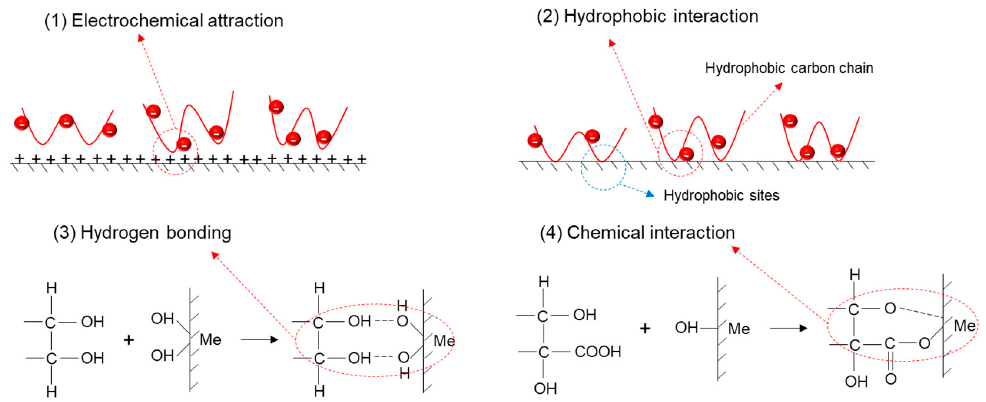
Figure 40. Possible mechanisms of interaction of organic polymers with the mineral surface: ( 1 ) elec- trochemical attraction, ( 2 ) hydrophobic interaction, ( 3 ) hydrogen bonds, and ( 4 ) chemical interaction. Figure adapted from (adapted from Mu et al. [160]).